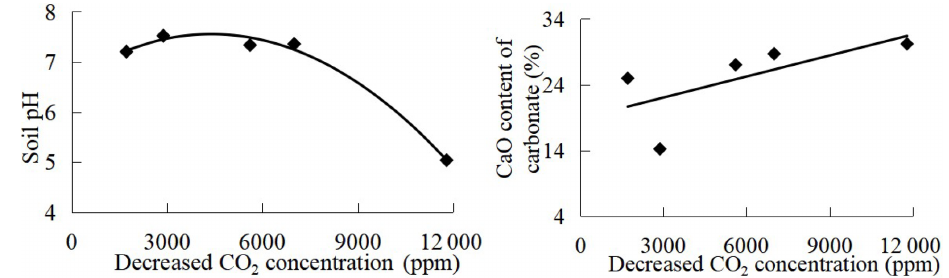
Figure 12. Correlation analysis of soil pH, CaO of carbonate, and decreased CO 2